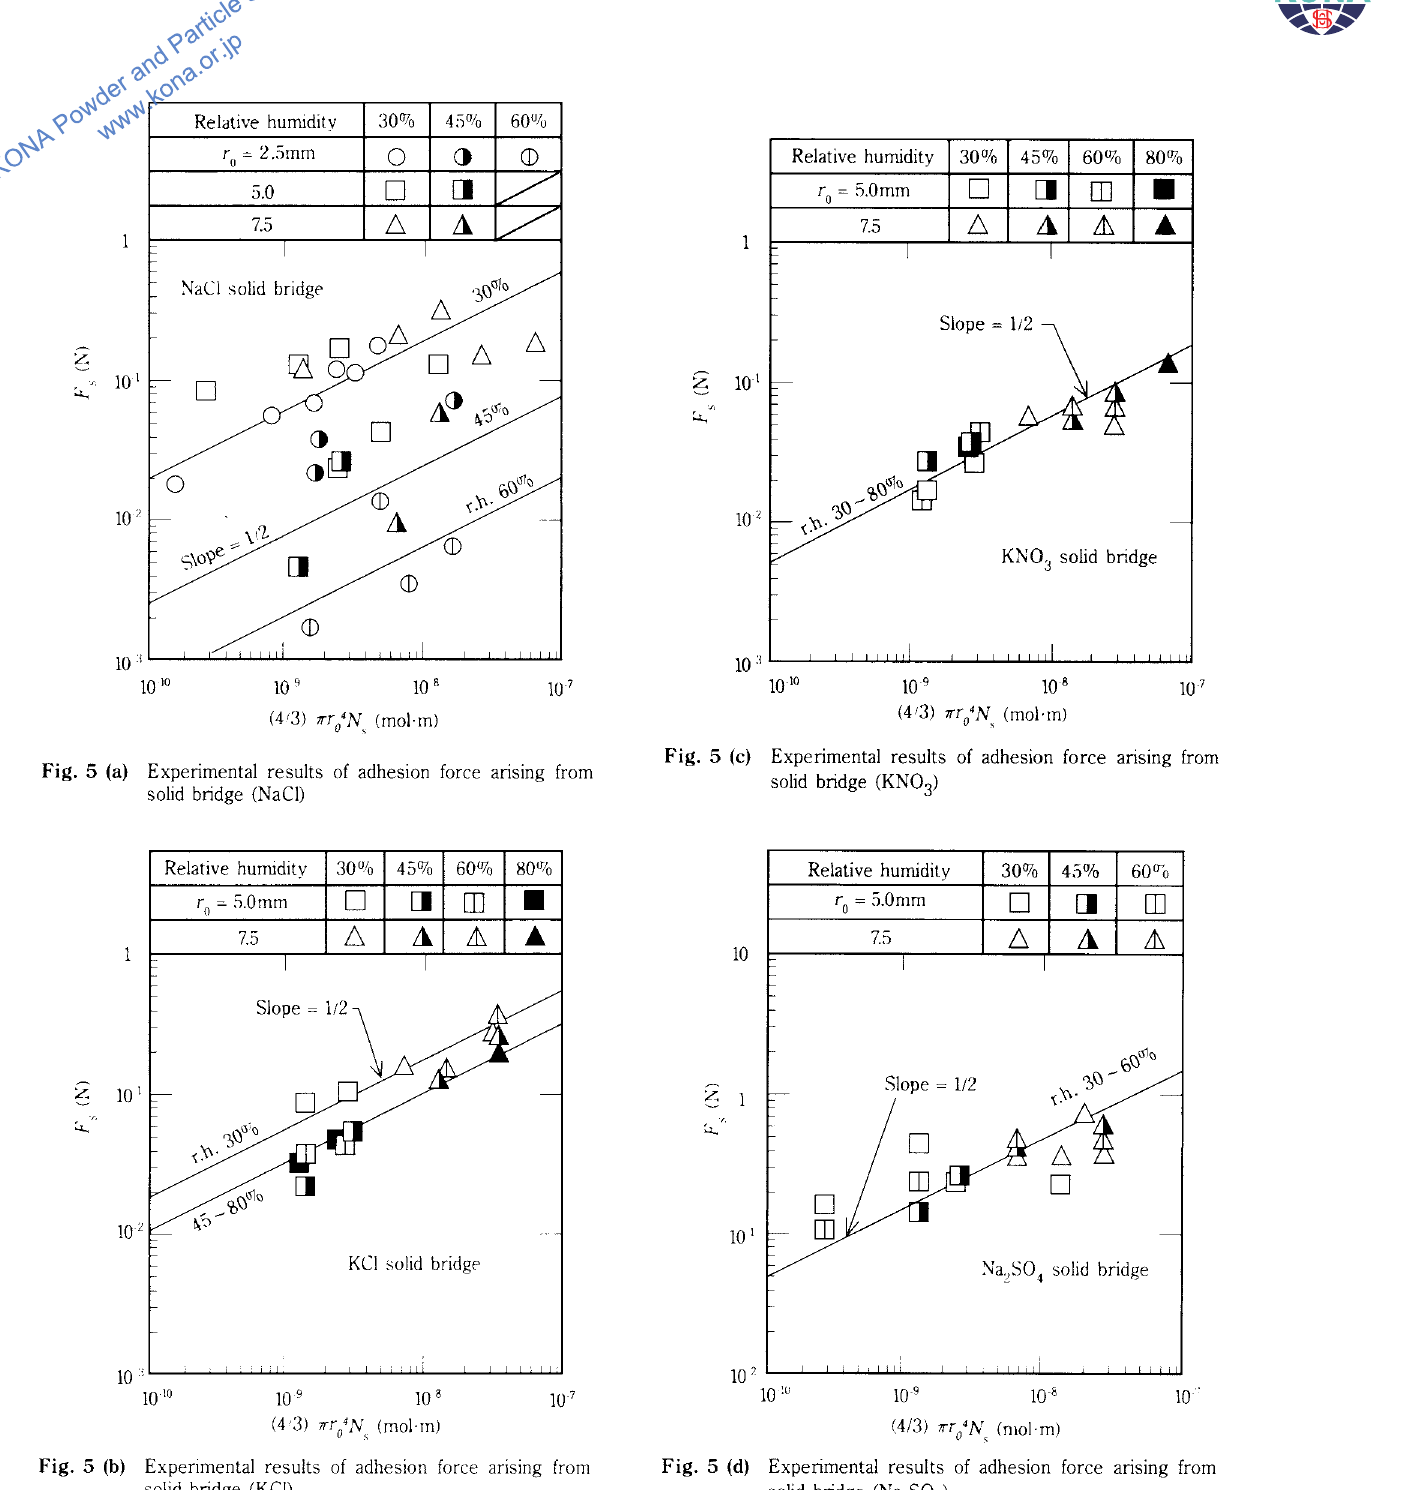
Fig. 5 (b) Experimental results of adhesion force arising from solid bridge (KC!)